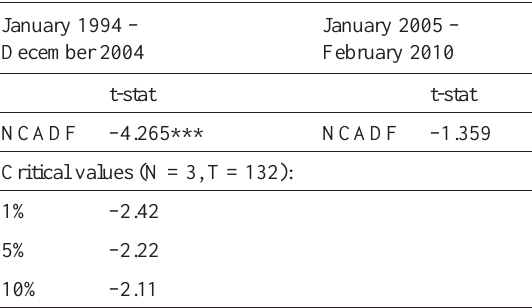
table 5. Panel test of rental price